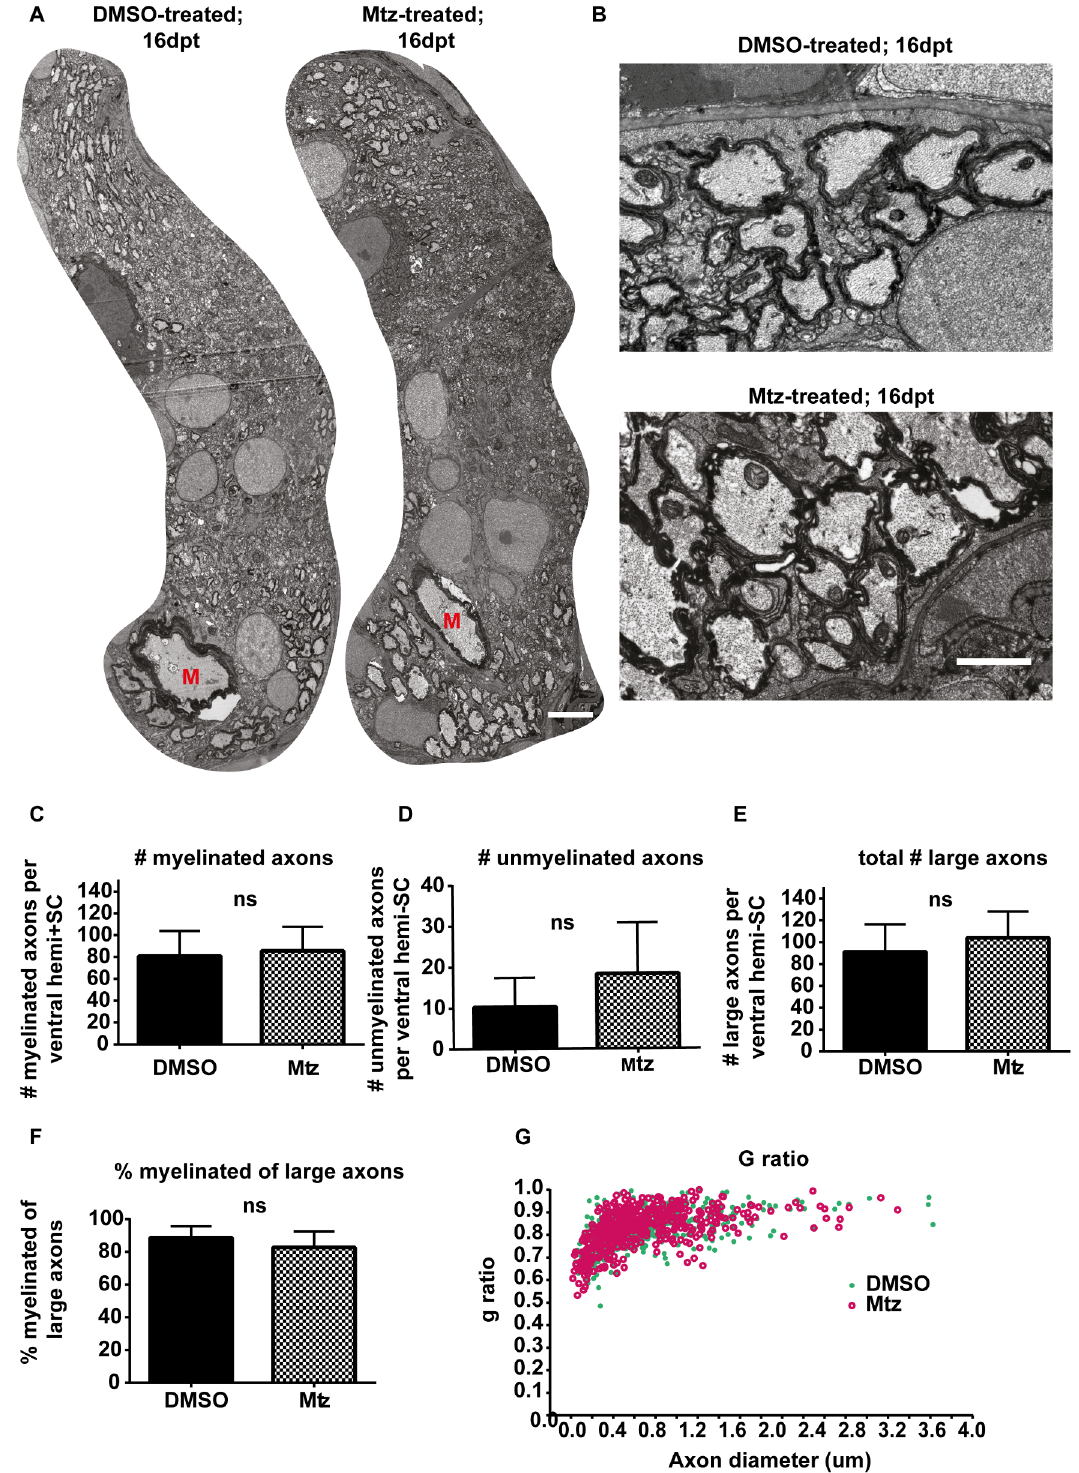
Fig 7. Remyelination occurs by 16 days post-treatment. A . Electron micrographs of entire hemispinal cords of DMSO- or Mtz-treated Tg(mbp:mCherry-NTR) larvae). Scale bar: 3 μ m. B. Higher magnification electronmicrographsof the ventral spinal cords. Scale bar: 1 μ m. C. Quantificationof the numbersof myelinatedaxons per ventral hemi-spinal cord. Mean in controls: 80.88 ± 23.12 vs treated: 85.71 ± 22.01, p = 0.686. D . Quantification of the number of unmyelinated axons < 1 μ m